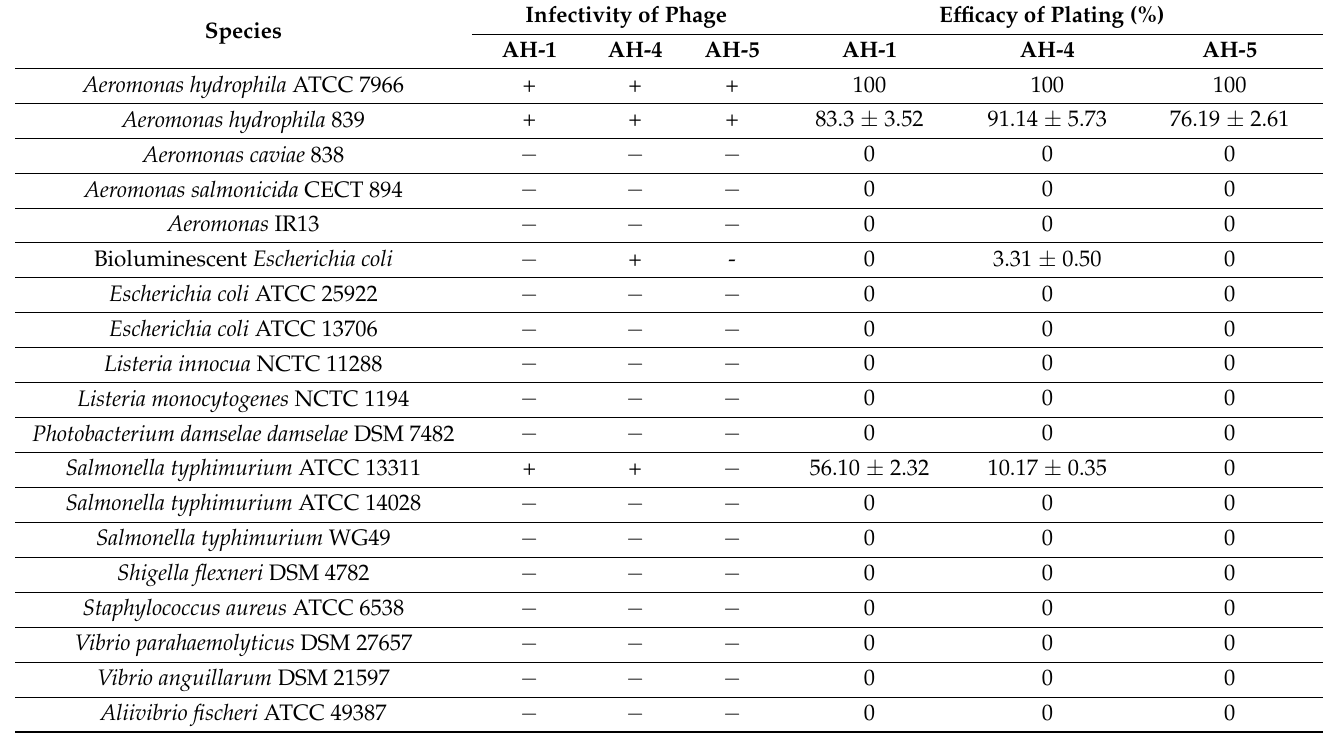
Table 1. Host range of phages AH-1, AH-4, and AH-5 determined on 19 bacterial strains. Clear lysis zone, (+); no lysis zone, ( − ). The plating with the host strain was considered as EOP = 100%.